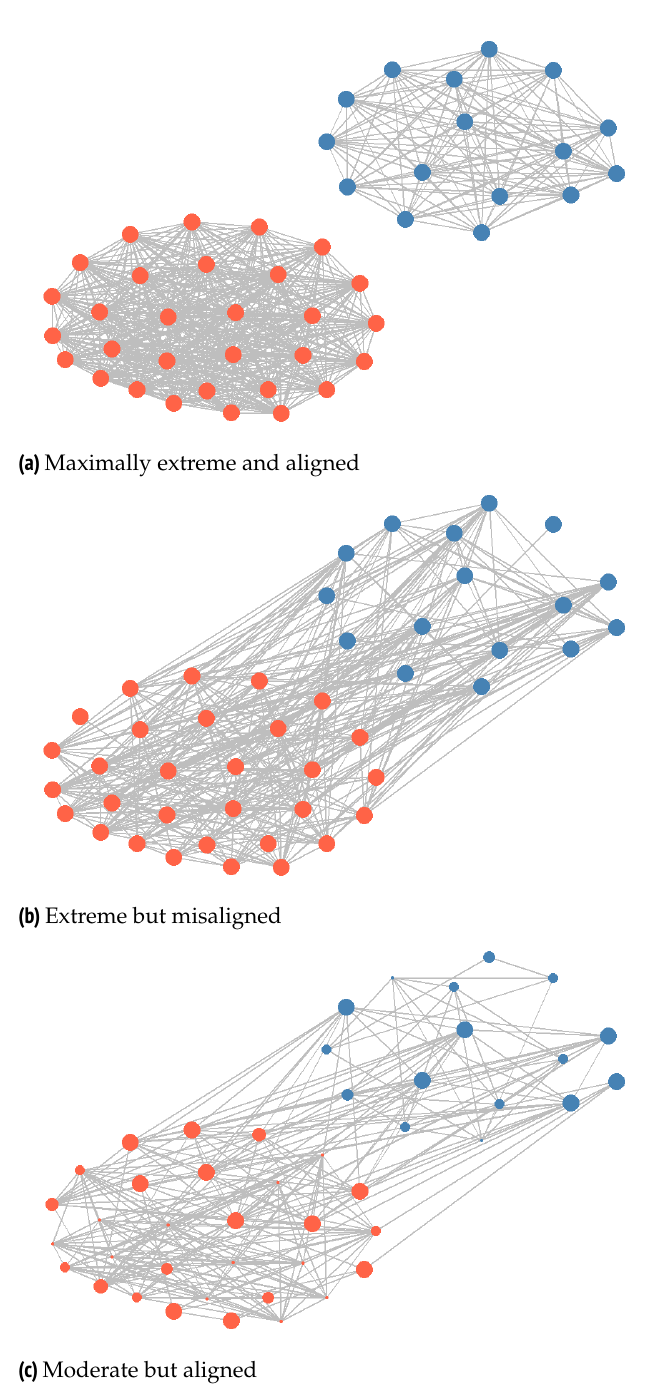
Figure 2: Individual attitude structures. Notes: Panels (b) and (c) are taken from actual GSS respondents. The node layout is based on the Kamada–Kawai algorithm of ties shown in panel (a). Node size is based on extremism. Ties indicate interdependent responses on